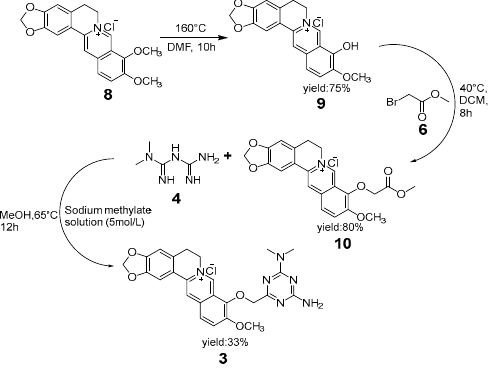
Scheme 2. Cyclization of compound 3 .